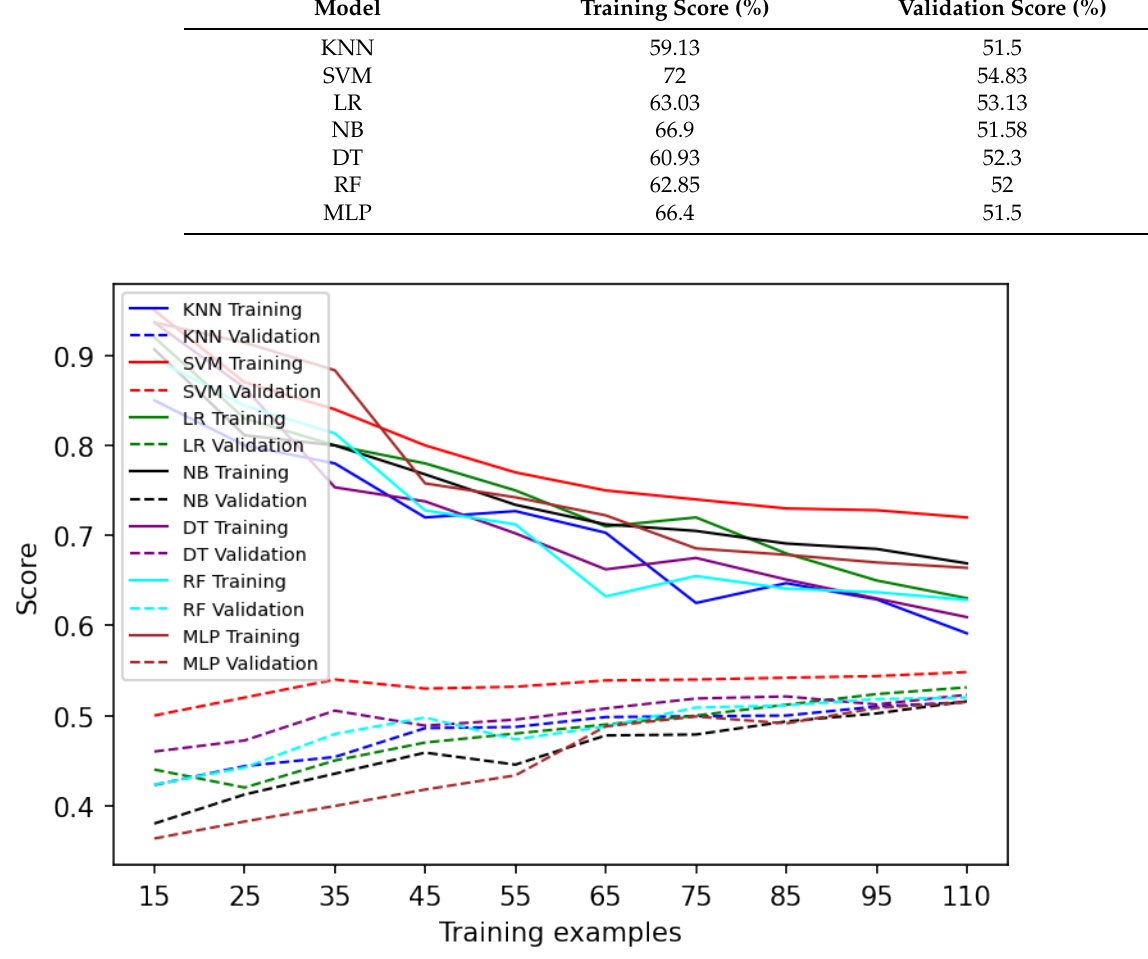
Figure 9. Average learning curve for all